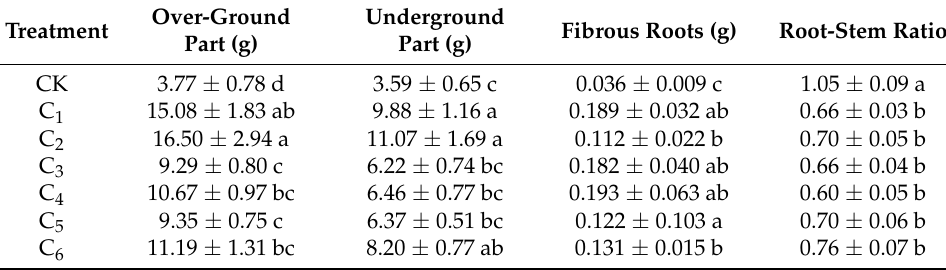
Table 3. The biomass of various parts of S. sebiferum container seedlings in different biochar treatments.